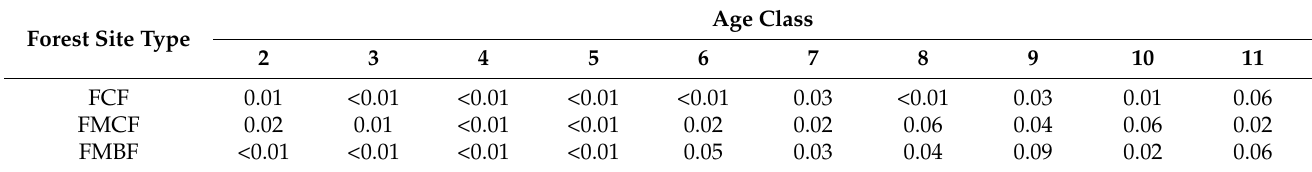
Table 4. R 2 results for the linear relationship between the growing stock volume on the plots and the natural logarithm calculated from the area of the forest patches.